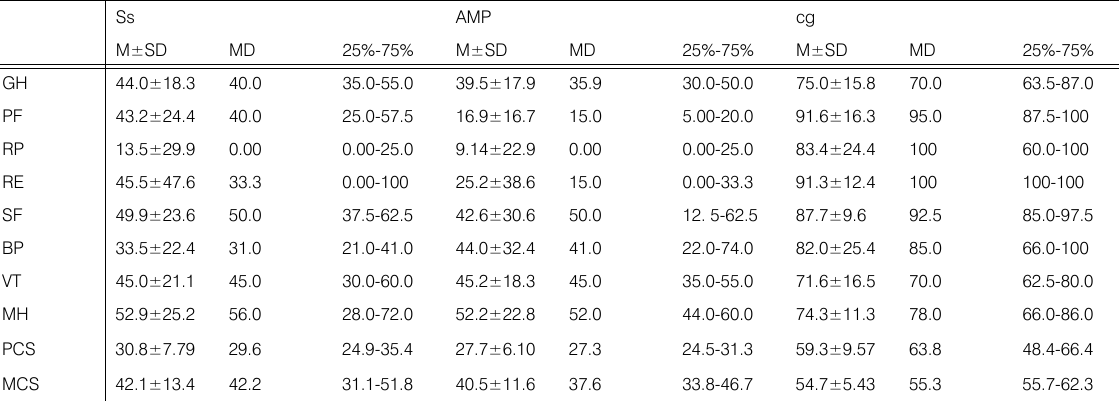
Table 2. SF-36 Score of study groups. SS-patients after spine surgery, AMP- patients after limb amputation, CG- control group (M-mean, SD- standard deviation,